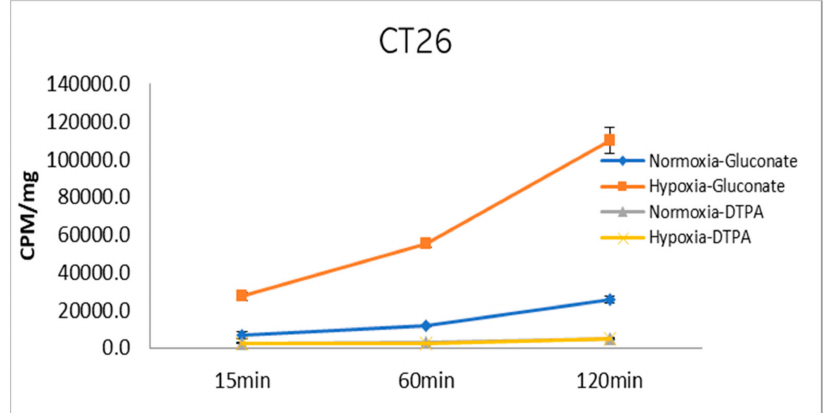
Figure 2. In vitro uptake of [ 99m Tc]Tc-gluconate and [ 99m Tc]Tc-DTPA. Cell uptake was measured under hypoxic and normoxic conditions. Cells were harvested at 15, 60, and 120 min, and the radioactivity was measured using a gamma counter. The value was expressed as CPM/mg of the total cellular protein. ( n =